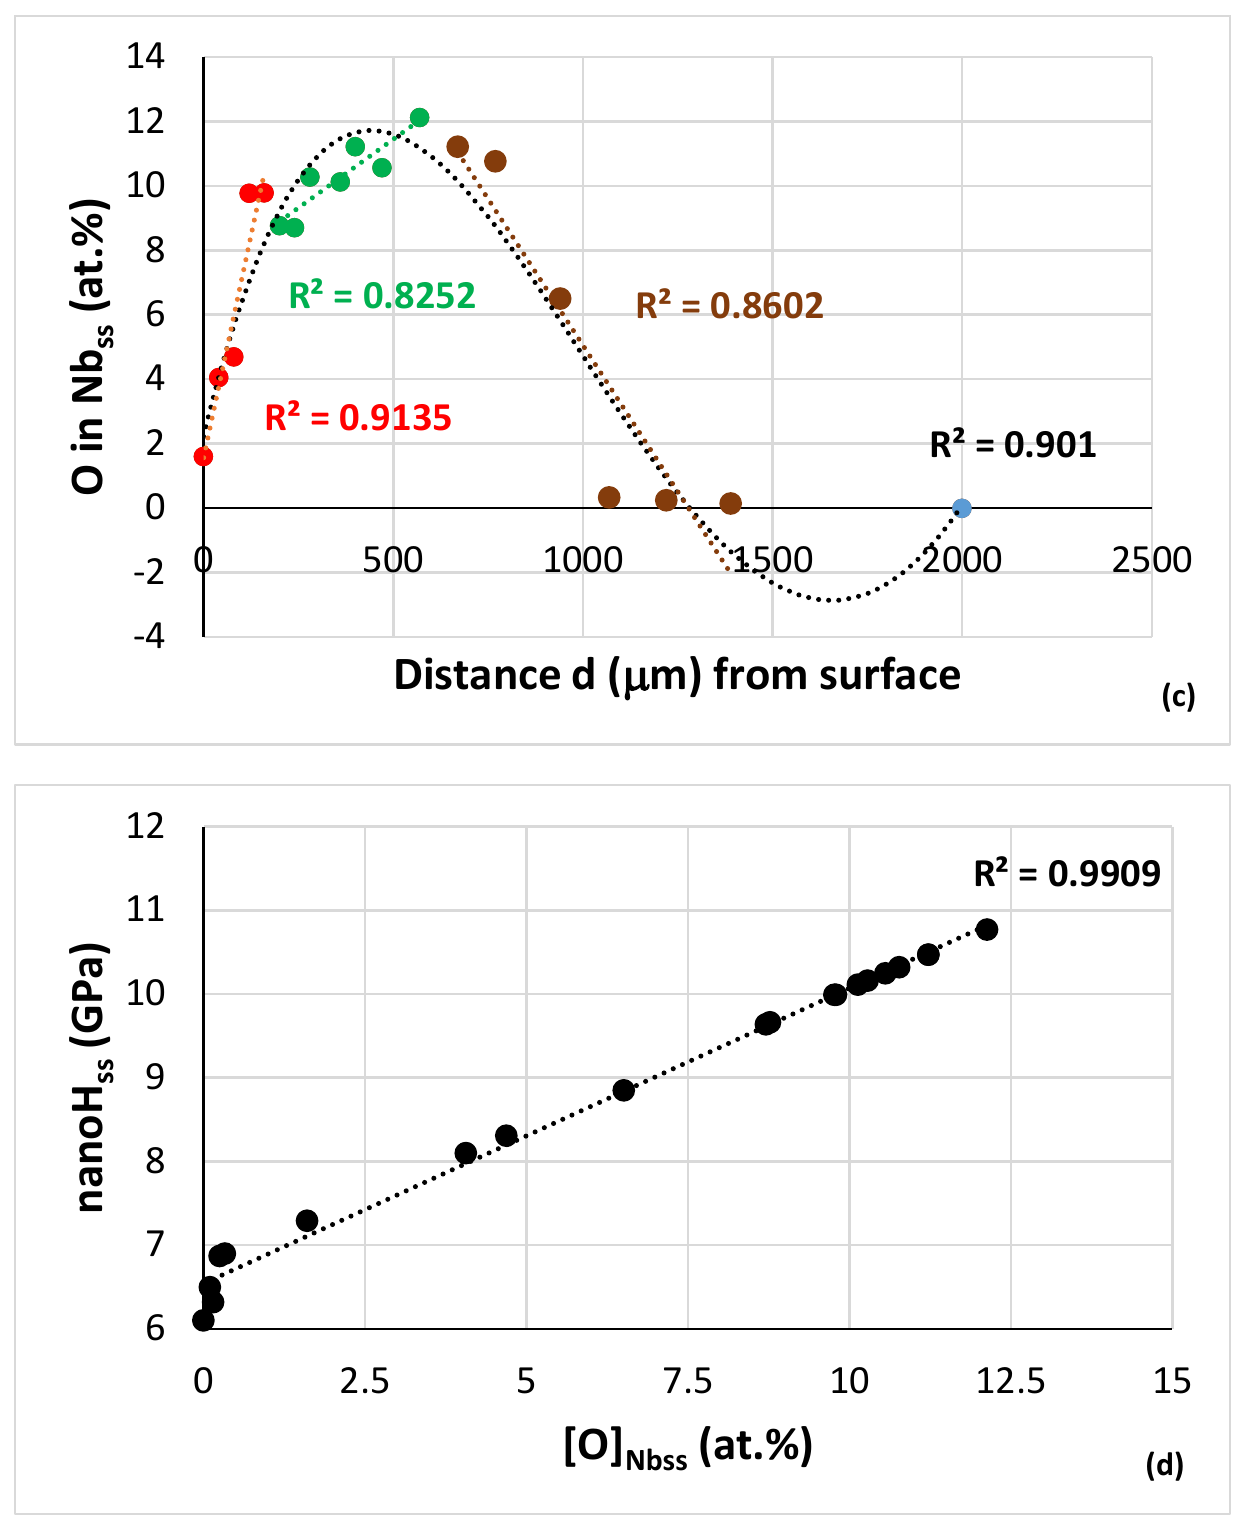
Figure 12. ( a ) Average nanohardness, ( b ) average Young’s modulus and ( c ) average oxygen concen- tration of the Nb ss in NV1-HT (1500 °C/100 h) as a function of distance from the surface of heat treated specimen. In each part, all the data fit to a 4th order polynomial (see text) with R 2 values 0.921, 0.8968 and 0.9016, respectively, for ( a – c ). ( d ) Nanohardness of Nb ss versus oxygen content. In Figure 12a the surface nanohardness is 7.29 GPa or 743.3 HV and corresponds to microhardness (microH) 548.2 HV based on the relationship microH Nbss = 0.7357 × na- noH Nbss (see [16]), whereas the maximum nanohardness of 10.77 GPa or 1098 HV at 570 m below the surface corresponds to microhardness 807.9 HV. In the area 2000 m below the surface the nanohardness was 6.1 GPa or 622 HV and corresponds to microH Nbss = 457.6 HV. This is lower than the hardness of the solid solution (523 HV) reported in [16], where the area of hardness measurement below the surface was not recorded. The surface hardness and the maximum hardness of the alloyed and contaminated with oxygen Nb ss in NV1-HT below the surface, respectively, was mo re than 7 and 10 times that of “uncon- taminated” Nb. Up to 15 times in crease in hardness has been reported for Nb contami- nated with 16 at.% C, i.e., for (Nb,C) ss [79]. The hardness of the contaminated with oxygen Nb ss in NV1-HT at the surface (548 HV), and 570 m below the surface (808 HV) was higher than the hardness of the (uncon- taminated?) single bcc solid solution phase RHEAs HfMoTaTiZr (542 HV), MoNbTaVW